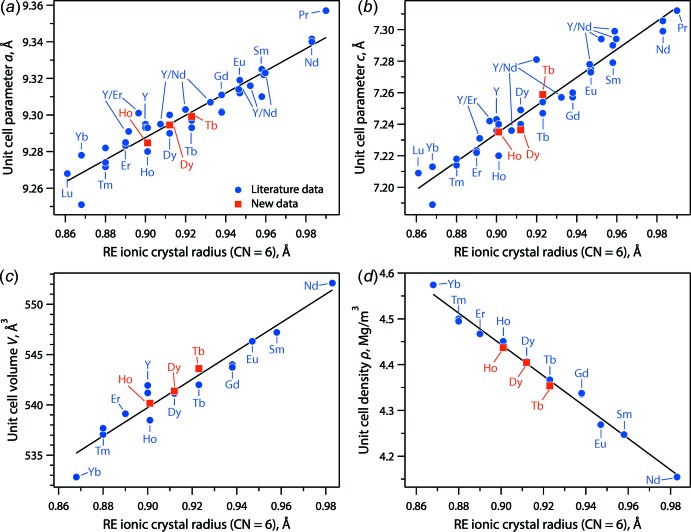
Summary of (a) unit-cell parameter a, (b) unit-cell parameter c, (c) unit-cell volume (V), and (d) density (ρ) as a function of the average ionic crystal radii of the RE in the crystal structures (coordination number = 6) from Shannon (1976 ▸).